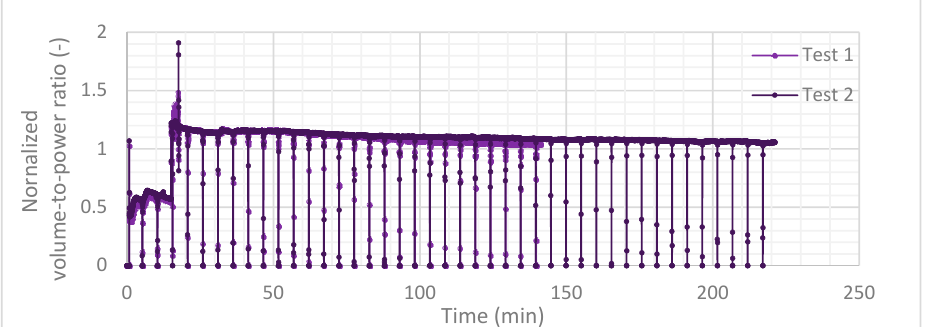
Figure A16. Normalized volume-to-power ratio at the thermostatic temperature of − 30 °C.